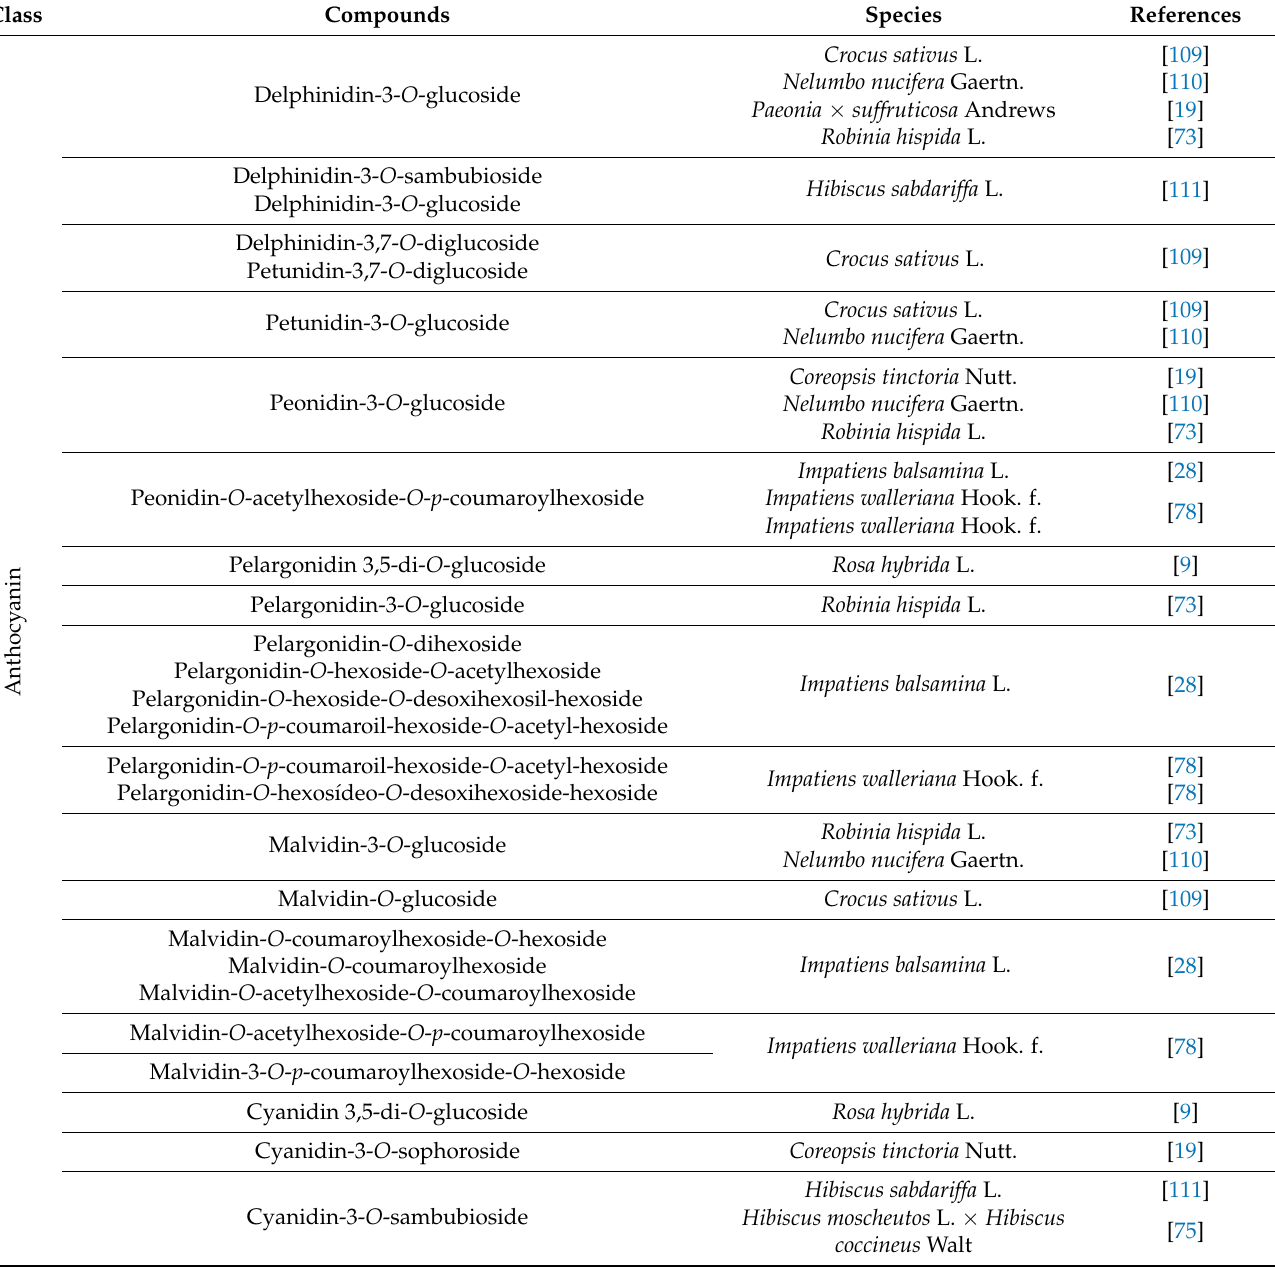
Table 2. The main flavonoids commonly found in edible